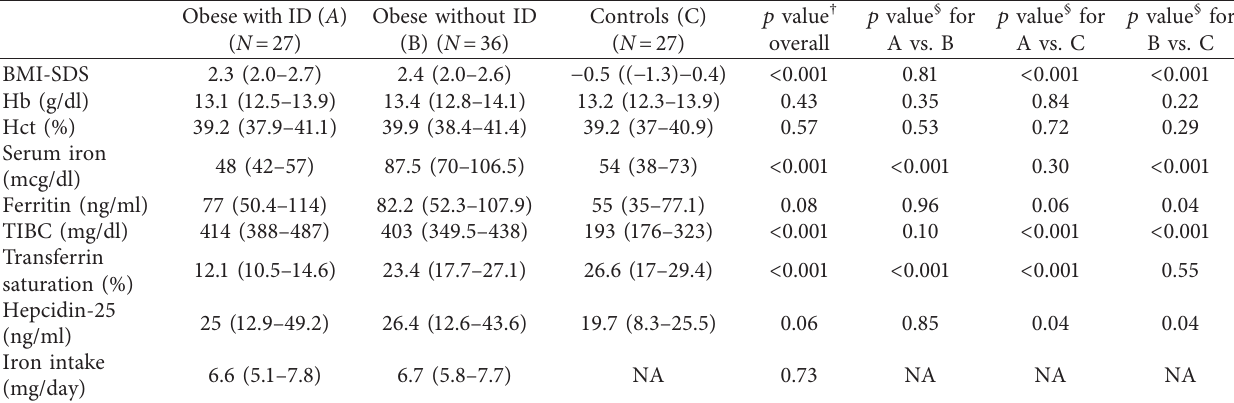
Table 3: Comparison of BMI-SDS, iron profiles, and serum hepcidin-25 among children with obesity and ID, children with obesity without ID, and controls.